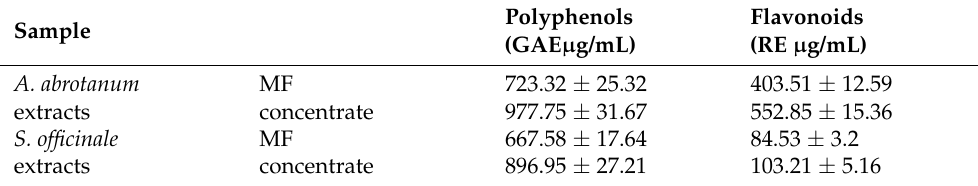
Table 1. The active biological polyphenolic compound content in the analyzed extracts.